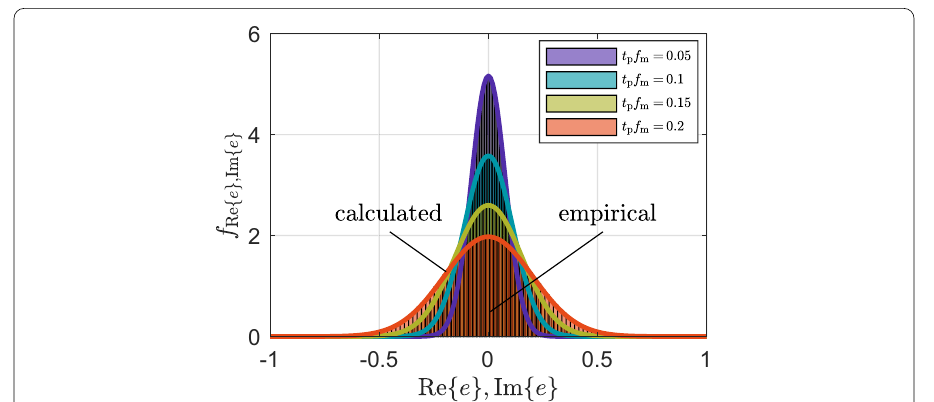
Fig. 13 Validation of the prediction error distribution